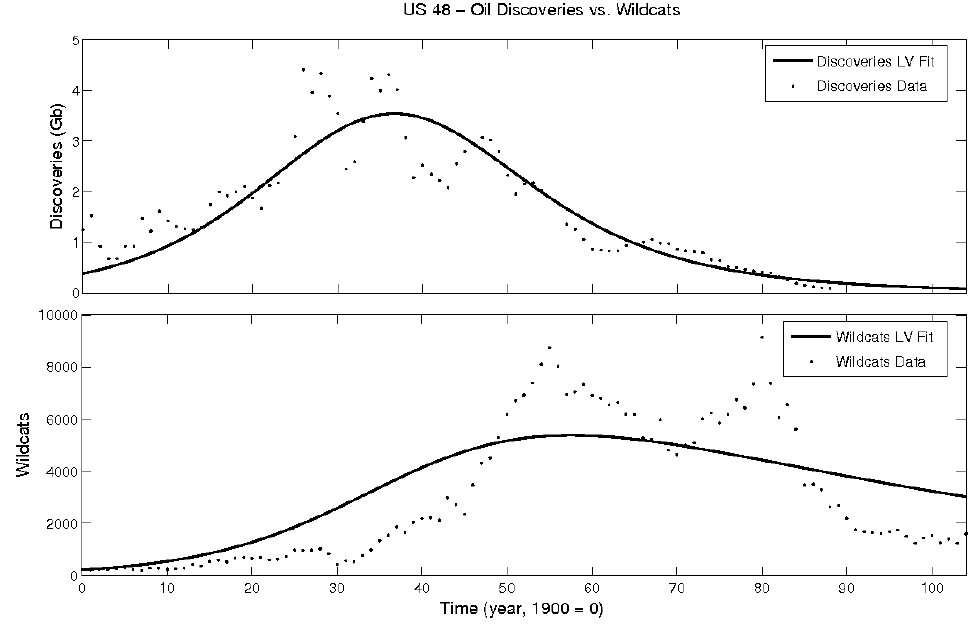
Figure 6 . Fitting of the data for oil discovery in the US 48 lower states and of the number of wildcats. In this case, the number of wildcats is proportional to the capital used by the oil industry in the effort of discovering the resource (oil wells). Data by courtesy of Messrs. Colin Campbell and Jean